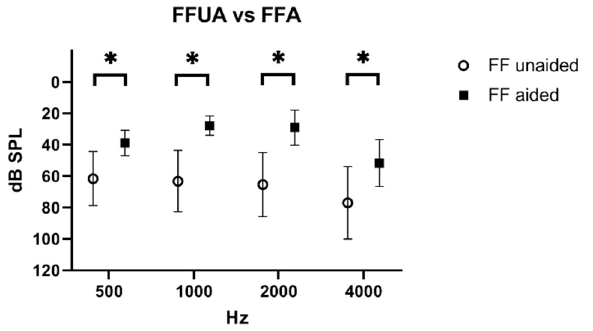
Figure 2. Free-field with a turned off (unaided) device compared to free-field with a turned on (aided) device (mean and SD). Significant differences are indicated with *.